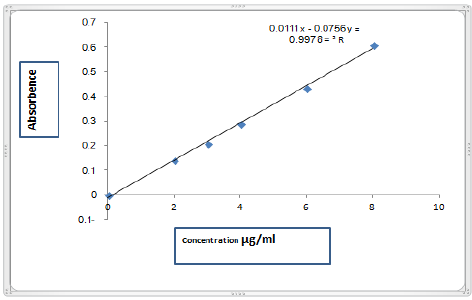
Figure 2: Calibration curve of Flurbiprofen in phosphate buffer (pH 6.8) and 37 °C.